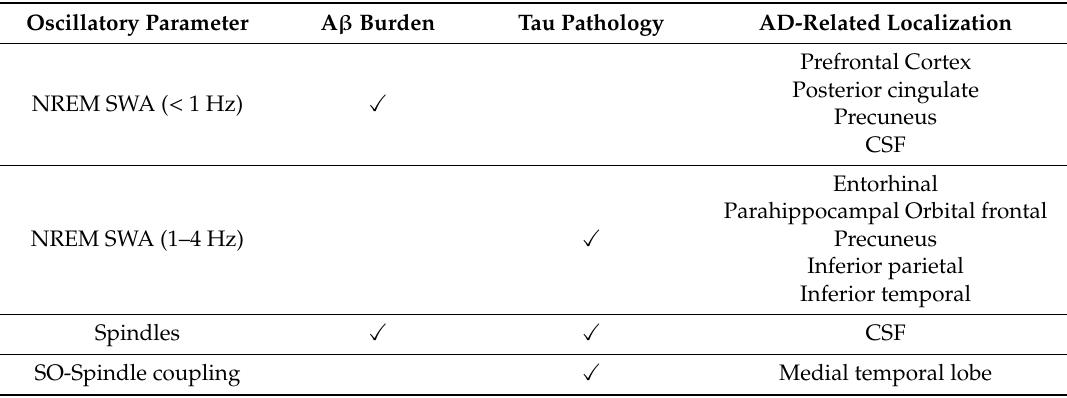
Table 1. Current evidence of possible sleep biomarkers and their association with gold standard Alzheimer’s disease (AD)